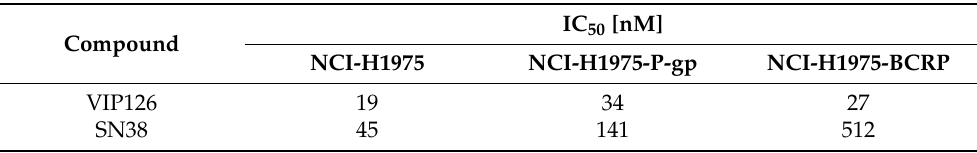
Table 2. Cytotoxic activity (IC 50 ) of VIP126 and SN38 in NCI-H1975 parental and efflux transporter- expressing mutant cells. The values represent the mean value of at least two independent assays performed in triplicate ( n = 3).